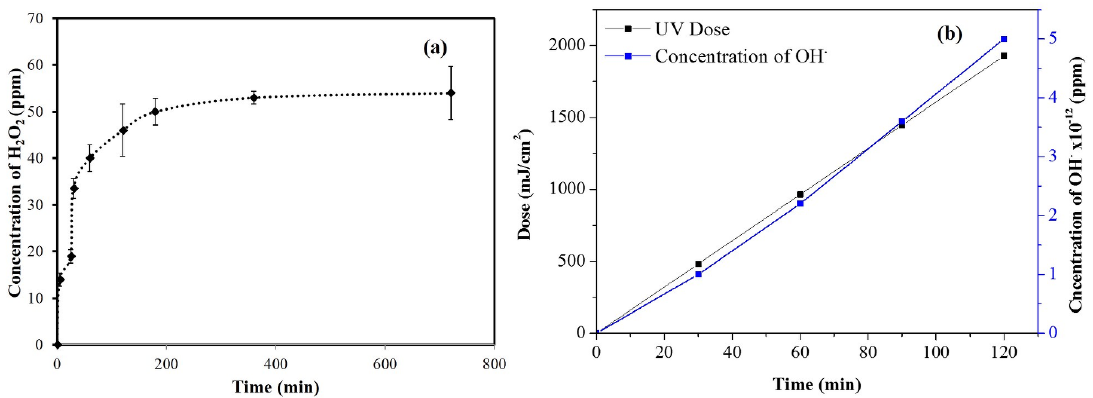
Figure 4. ( a ) H 2 O 2 produced from aqueous suspensions of MgO 2 under ambient laboratory conditions. ( b ) OH · radicals produced from aqueous suspensions of MgO 2 under LP-UV irradiation.